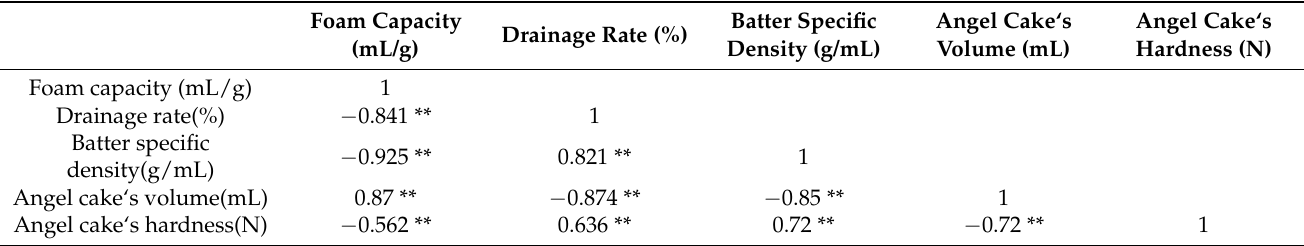
Figure 7. Cross section of angel cake sample. Samples mixed with ( a ) 0.5%wt EY and ( b ) 1%wt EY; ( c ) Volume of angel food cake. (black filled square represents the amount of contamination mixed with 0.5% EY; red filled circle represents the amount of contamination mixed with 1% EY). Different letters for the same parameter indicate significant differences ( p < 0.05) between treatments. Table 4. Results of correlation